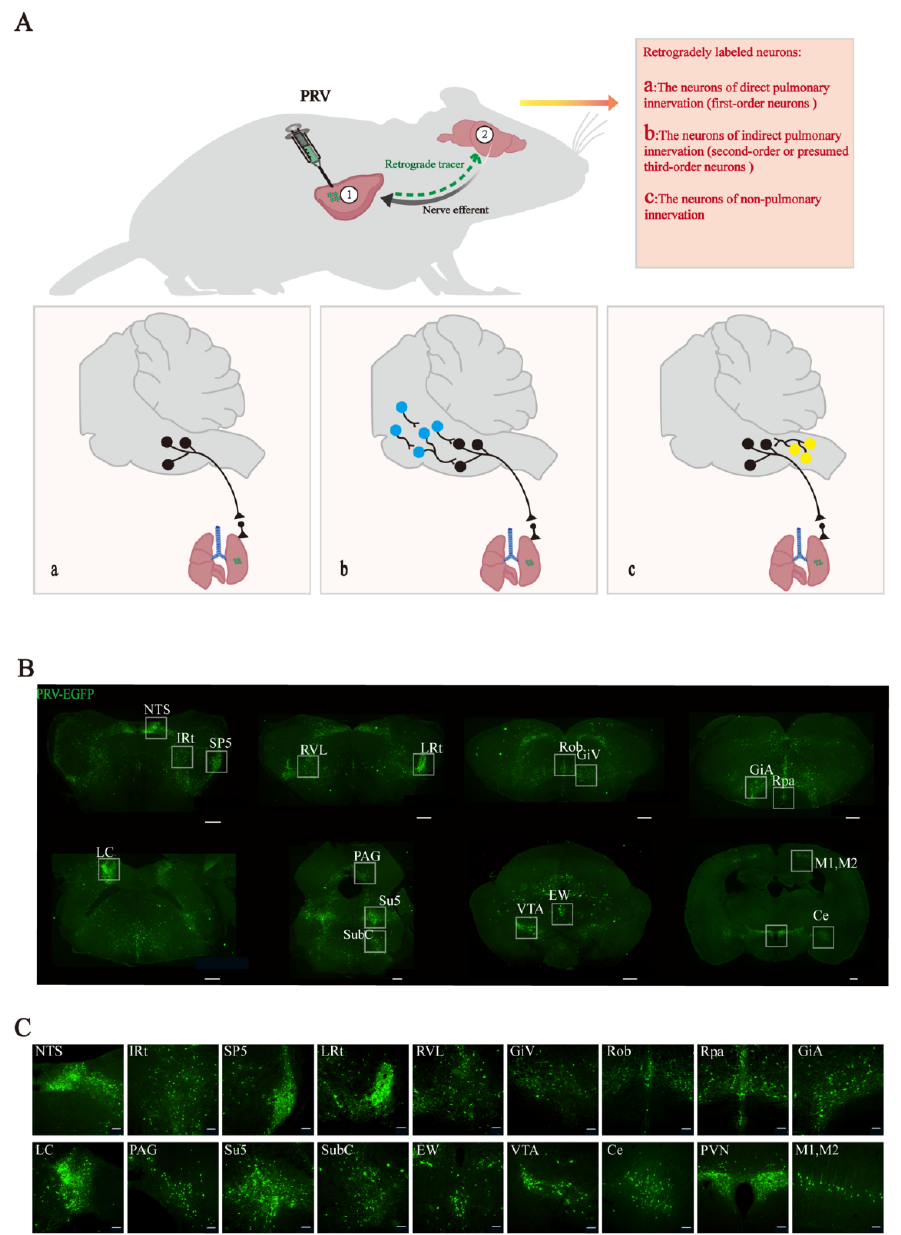
Figure 1. Schematic diagram of retrograde labeling of pseudorabies virus lungs and virus tracer- positive brain regions. ( A ) In situ injection of pseudorabies virus in the left lung of mice. The neuronal projections between retrogradely labeled neurons and lung tissue can be divided into direct pulmonary innervating neurons ( a ), indirect pulmonary innervating neurons ( b ), and nonpulmonary innervating neurons ( c ). ( B ) Overview of coronal sections of pseudorabies virus retrogradely labeled brain regions (scale bar = 400 µ m). ( C ) Enlarged brain sections retrogradely labeled by pseudorabies virus (scale bar = 100 µ m). NTS = nucleus tractus solitarius, IRt = intermediate reticular nucleus, SP5 = spinal trigeminal nucleus, LRt = lateral reticular nucleus, RVL = rostroventrolateral reticular nucleus, GiV = gigantocellular reticular nucleus, ventral part, ROb = Raphe obscurus nucleus, RPa = Raphe pallidus nucleus, GiA = gigantocellular reticular nucleus, alpha part, LC = locus coeruleus, PAG = periaqueductal grey, Su5 = supratrigeminal nucleus, SubC = subcoeruleus nucleus, EW = Edinger–Westphal nucleus, VTA = ventral tegmental area, M1,M2 = primary, secondary motor cortex, PVN = paraventricular hypothalamic nucleus, and Ce = central amygdaloid